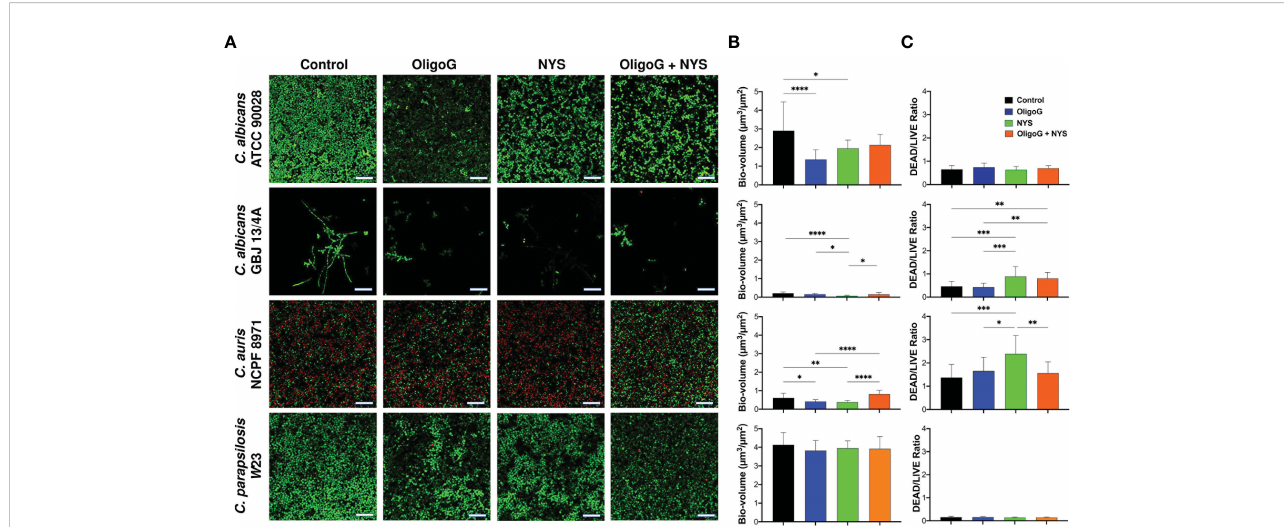
FIGURE 4 CLSM imaging of the disruption of 24 h grown C. albicans ATCC 90028, C. albicans GBJ 13/4A, C. auris NCPF 8971 and C. parapsilosis W23 established bio fi lms treated with 4% OligoG ± 2 m g/ml nystatin (NYS) for a further 24 h. (A) Z-stack imaging; scale bar = 40 m m. Corresponding COMSTAT analysis of (B) bio fi lm biomass (µm 3 /µm 2 ) and (C) DEAD to LIVE bacterial ratio; (n=3). Group wise comparisons were analysed using one-way ANOVA followed by Tukey ’ s post hoc tests *p < 0.05; **p < 0.01; ***p < 0.001; ****p <